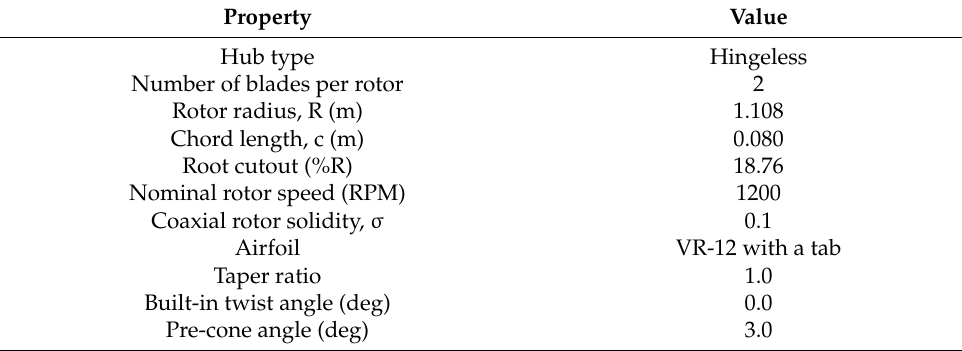
Figure 4. Coaxial co-rotating rotor model for test [1,20,21]: ( a ) Test stand; ( b ) rotor hub. Table 1. Properties of the coaxial co-rotating rotor [1,20,21].